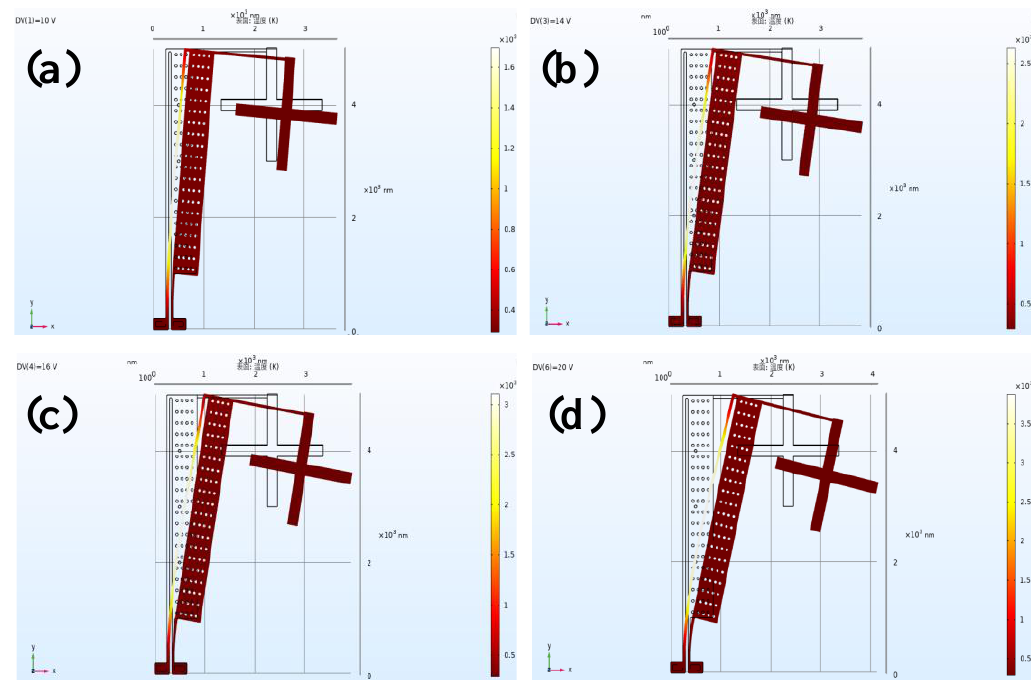
Figure 5. Simulated surface thermal flows of electrothermal actuator at the driving voltages of ( a ) 12 volts, ( b ) 14 volts, ( c ) 16 volts, and ( d ) 20 volts, respectively.